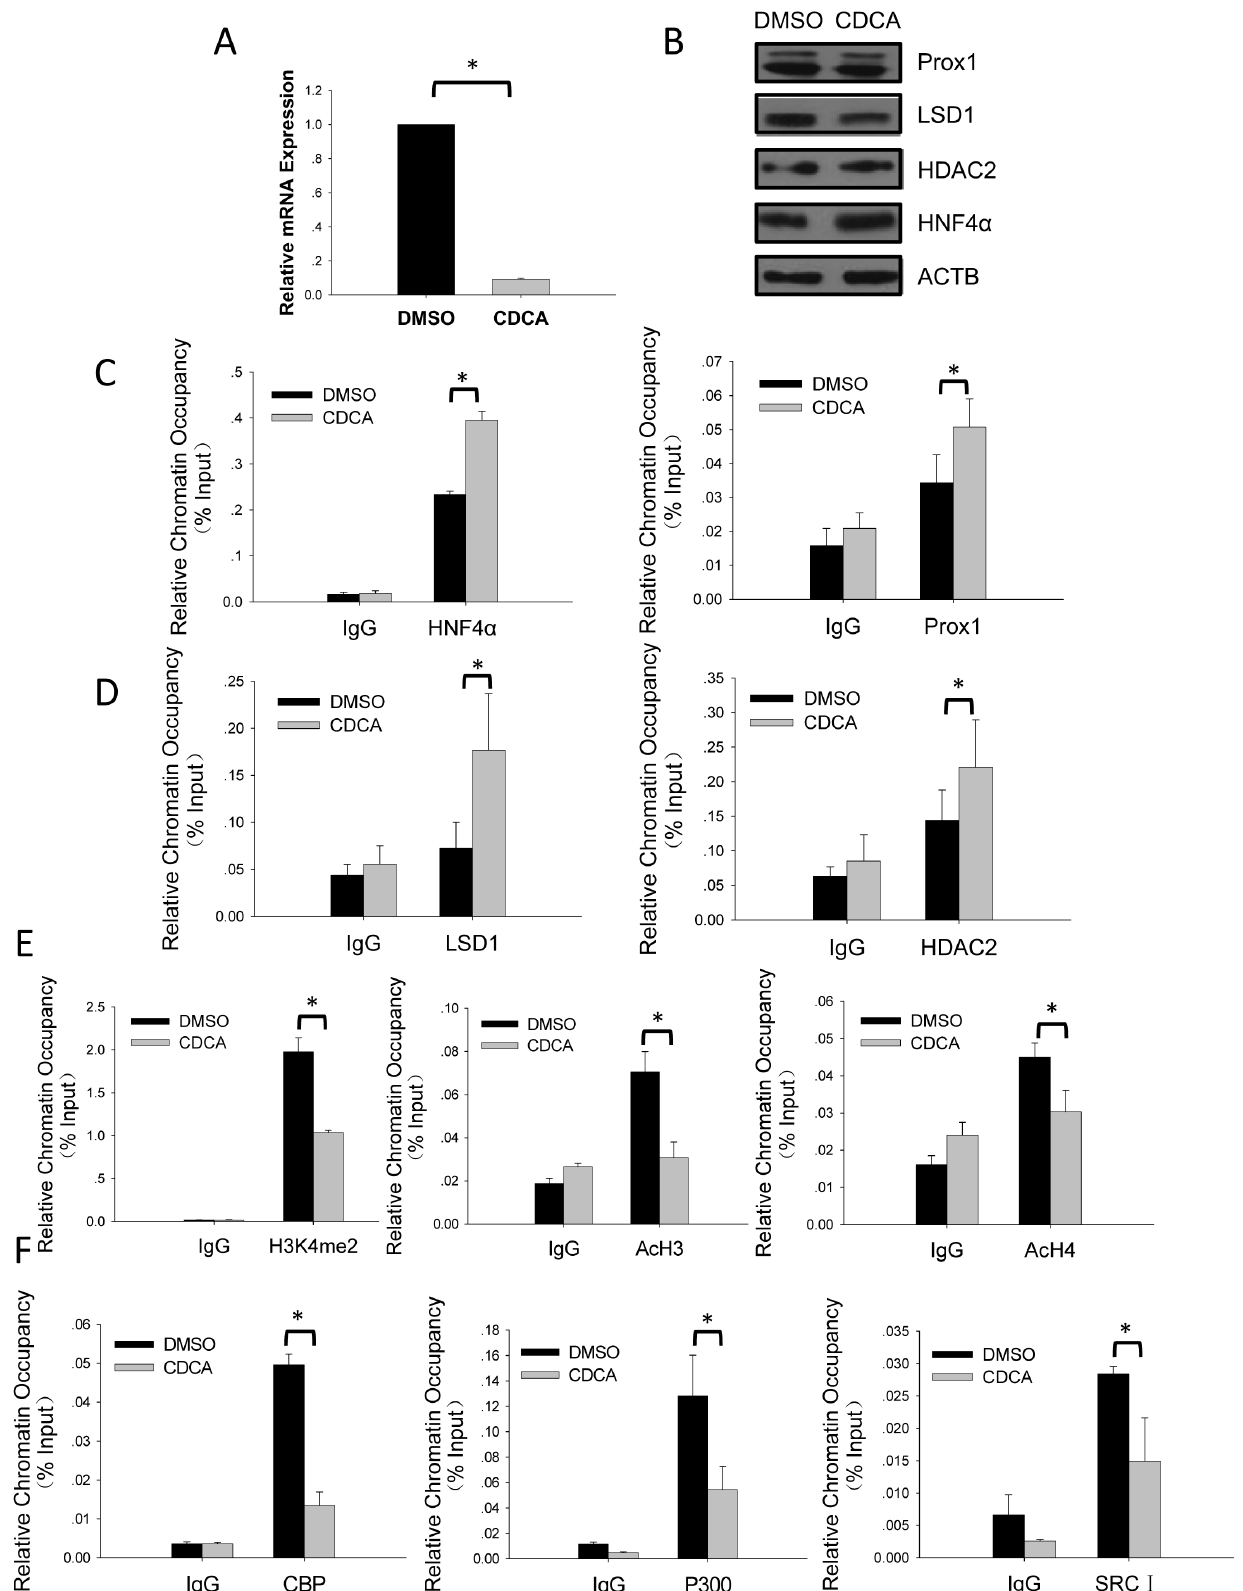
Figure 5. Prox1-mediated recruitment of LSD1/NuRD complex to CYP7A1 promoter participates in bile acids induced repression of CYP7A1 . (A) Chenodeoxycholic acid (CDCA) treatment of HepG2 cells results in repression of CYP7A1 transcription. Total RNA from HepG2 cells